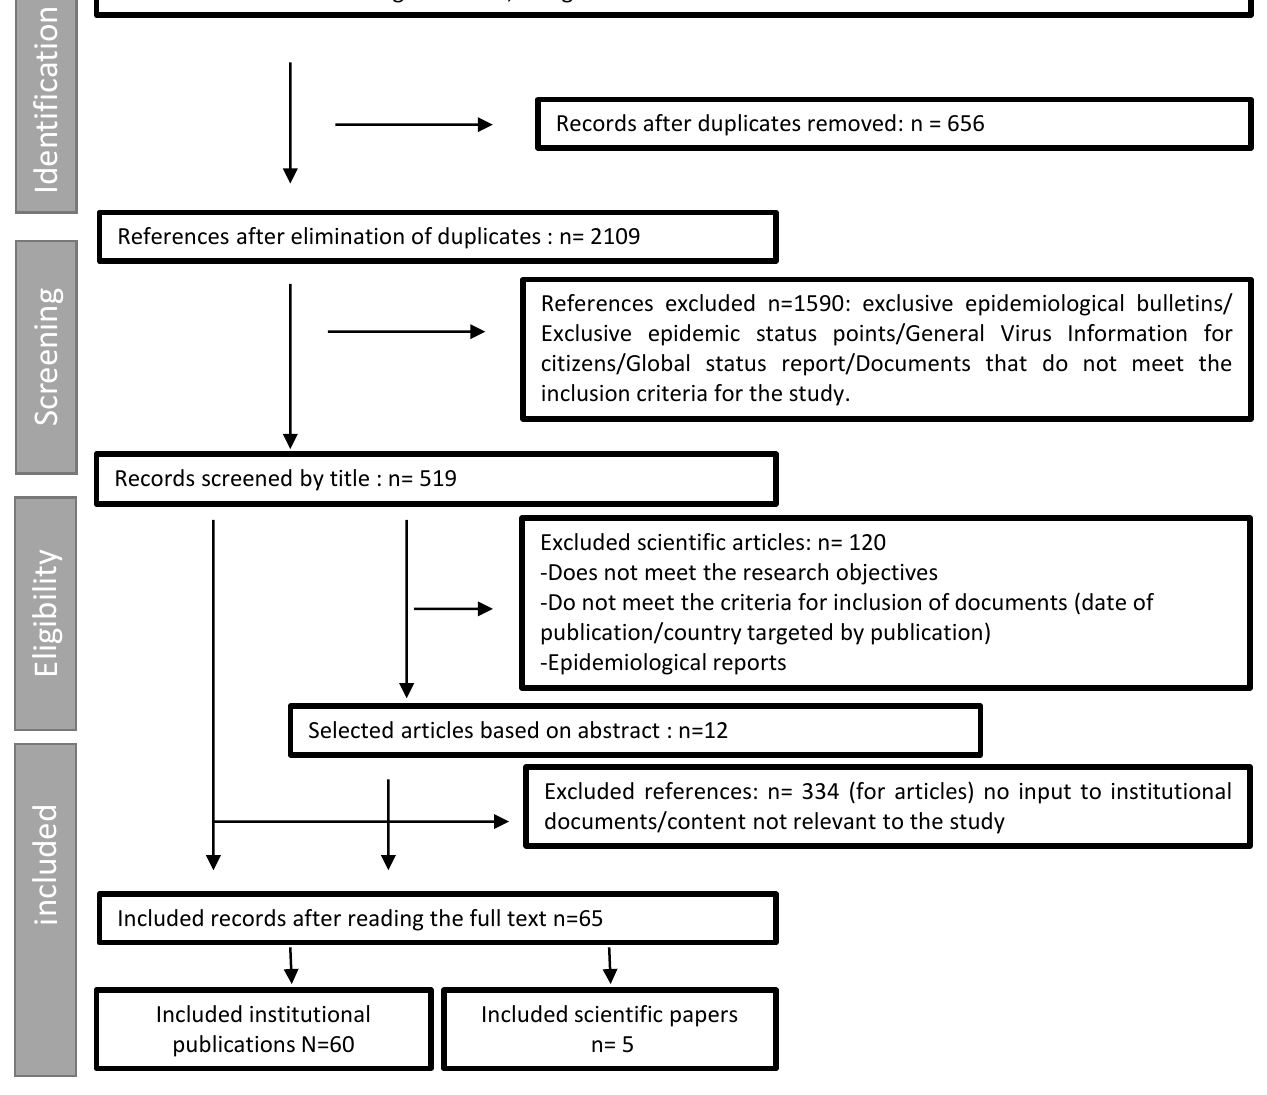
Figure 3. Flow diagram of the review process.